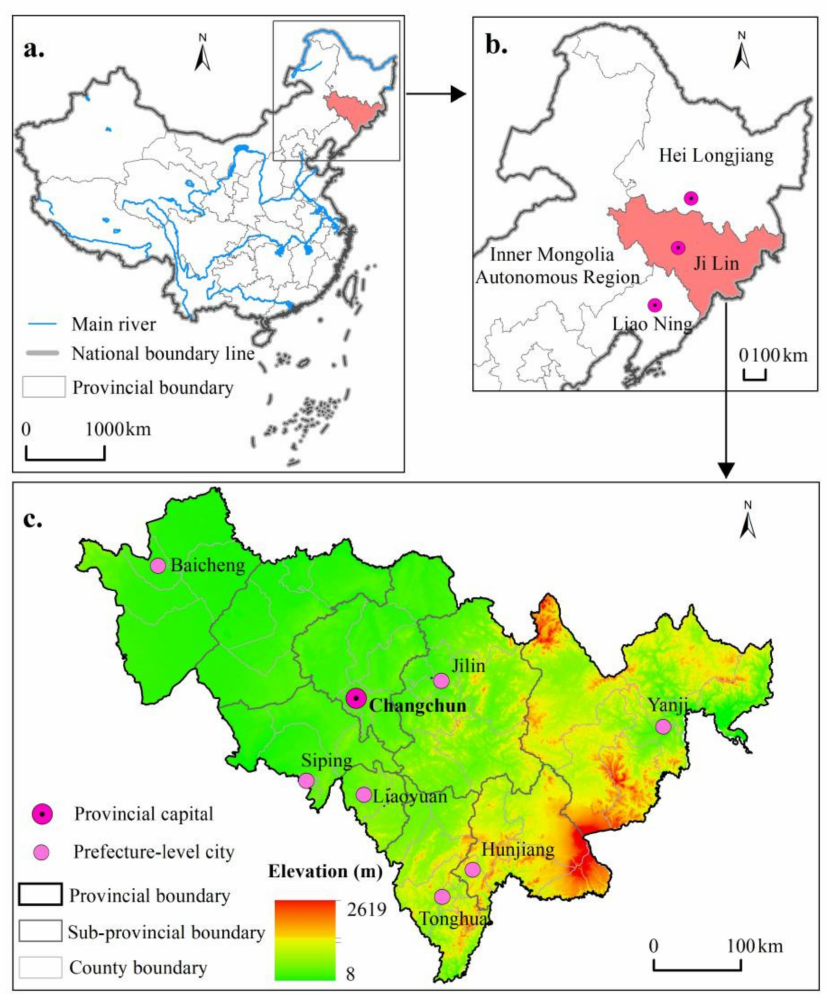
Figure 5. Map of the study area. ( a ) Geographic location of the study area within China; ( b ) Geo- graphic location of the study area within northeastern China; ( c ) Administrative boundaries, cities, and elevations in Jilin Province.